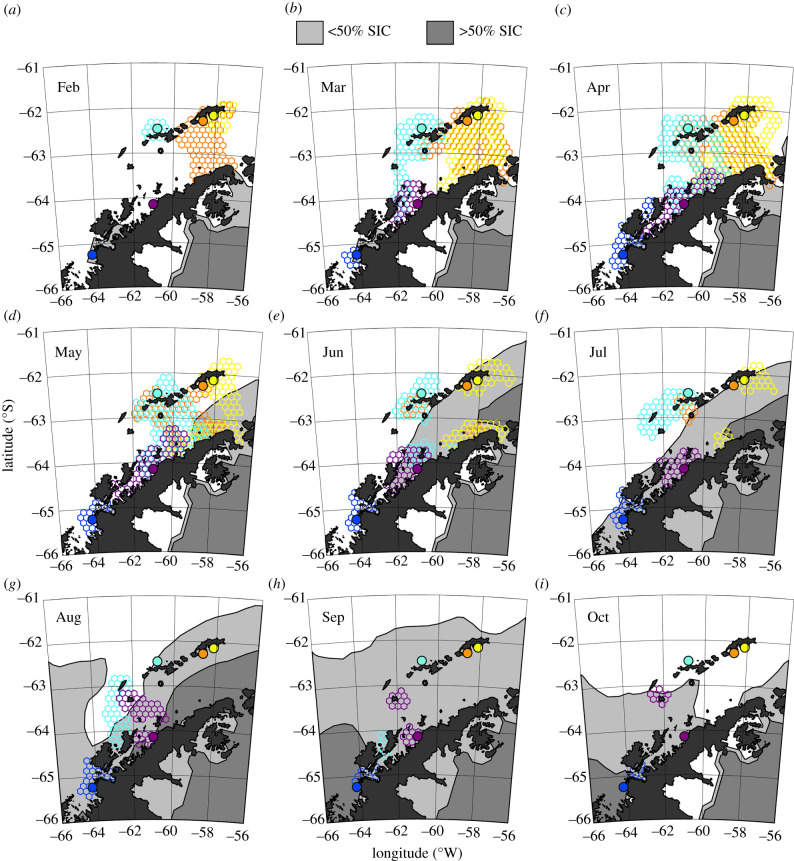
Monthly extents of colony-specific HUDs overlaid on monthly SIC. Colony locations are identified by filled circles. Colony locations and their HUDs are coloured as in figure 1.